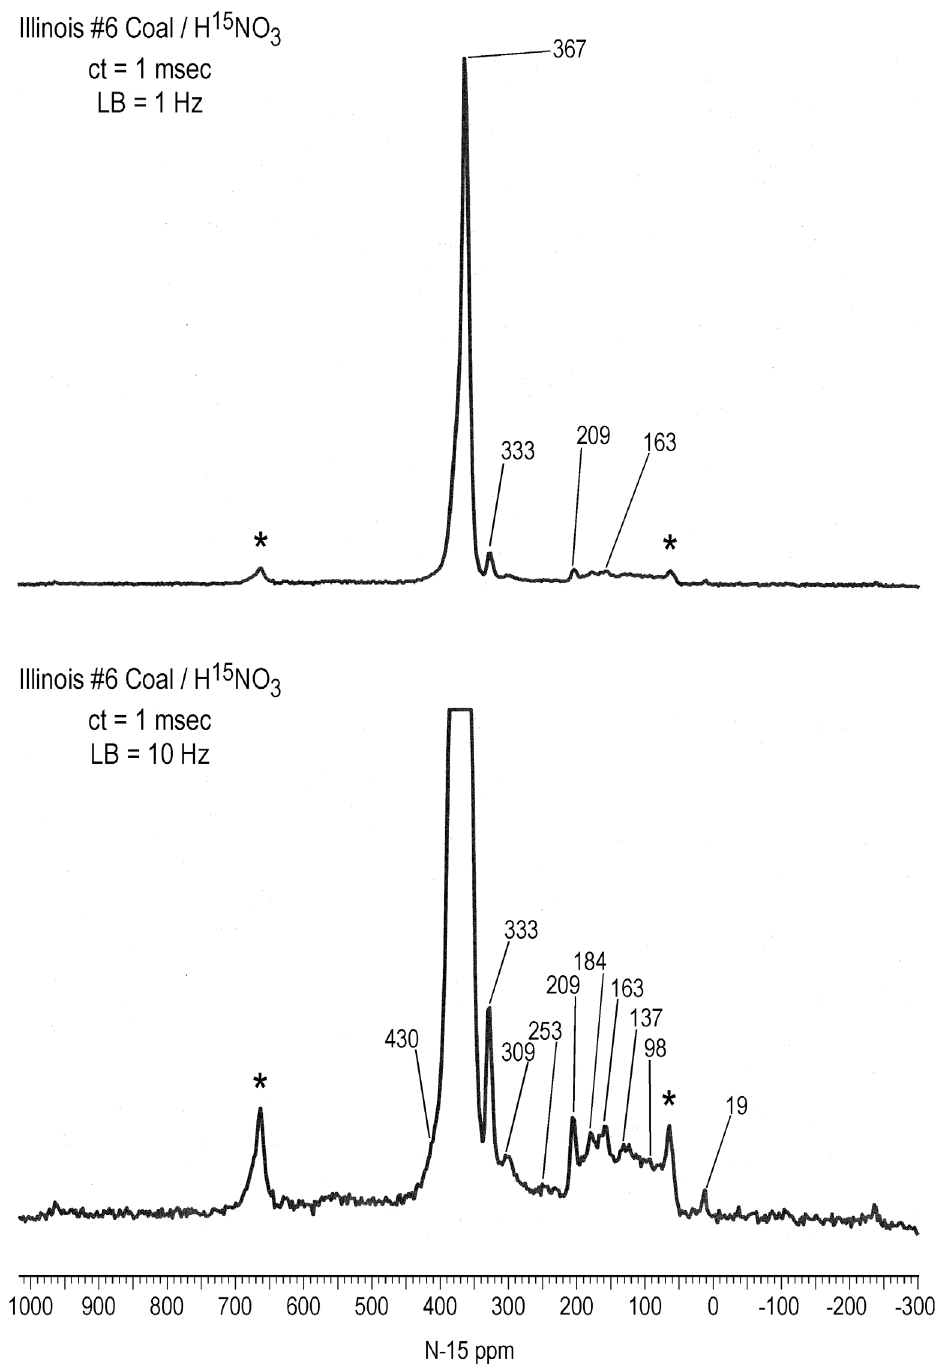
Fig 8. Solid state CP/MAS N-15 NMR spectra of Illinois #6 coal treated with N-15 labeled nitric acid. Bottom spectrum is vertical expansion. ct = contact time. LB = line broadening. Spinning speed = 6 kHz. Asterisks denote spinning